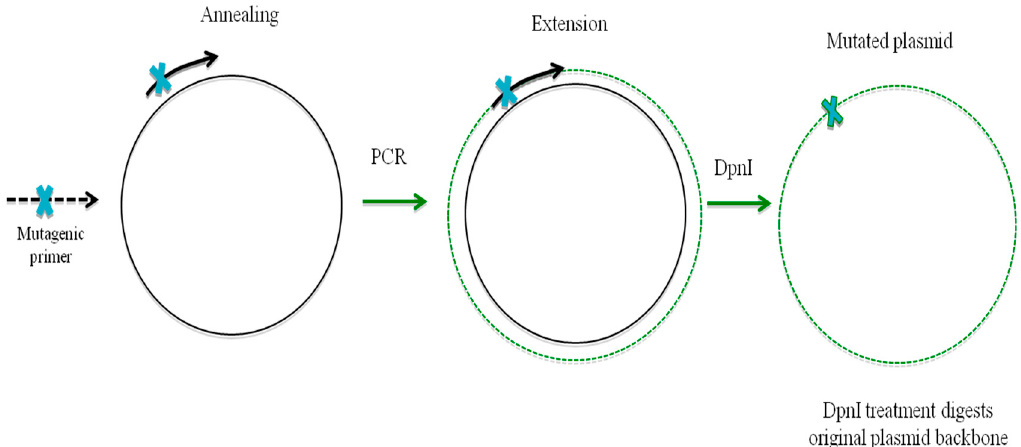
Figure 8. PCR based site directed mutagenesis: Mutated primers complimentary to the plasmid sequence are designed and later PCR based amplification resulting from the extension of the annealed primer completes the synthesis of the new mutated plasmid that harbors a mutation introduced through the primer. DpnI digestion removes the methylated parental non-mutated plasmid sequences, leaving the newly synthesis plasmid for future transformation experiments.